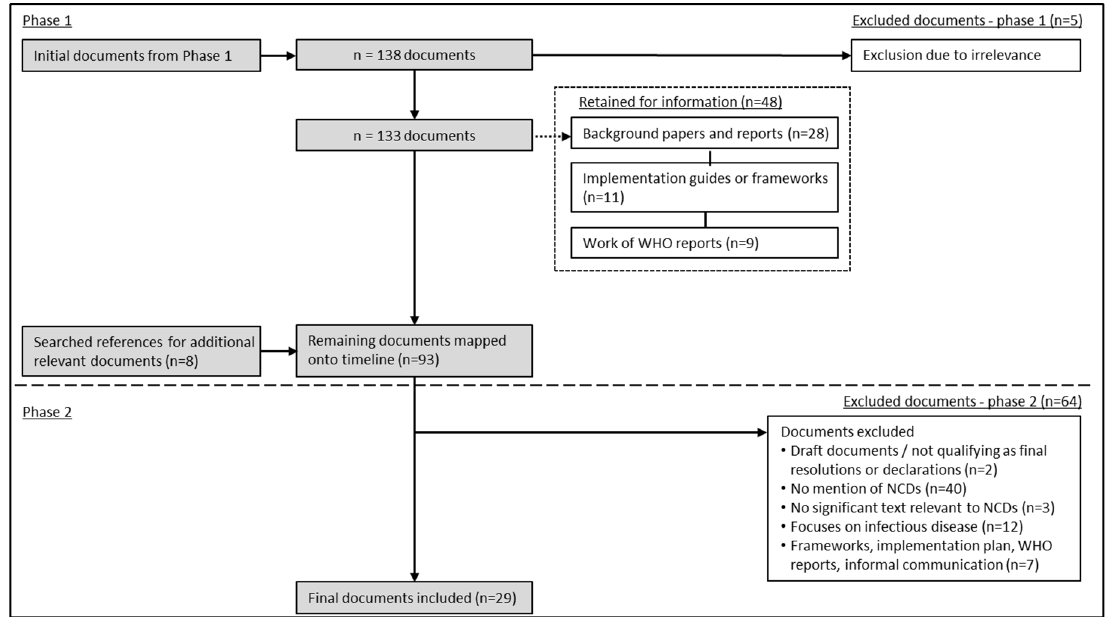
Figure 2. Flow diagram of search process of policy documents for the African region.